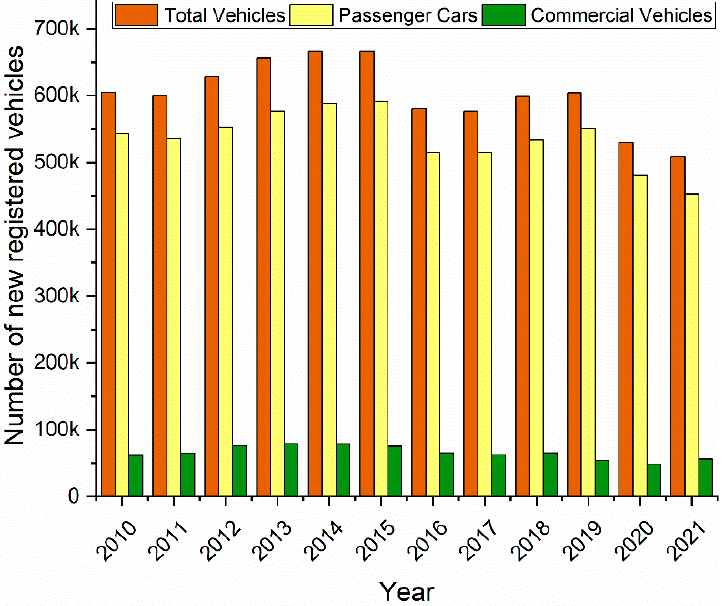
Figure 1. New passenger and commercial vehicles registered in Malaysia from 2010 to 2020.